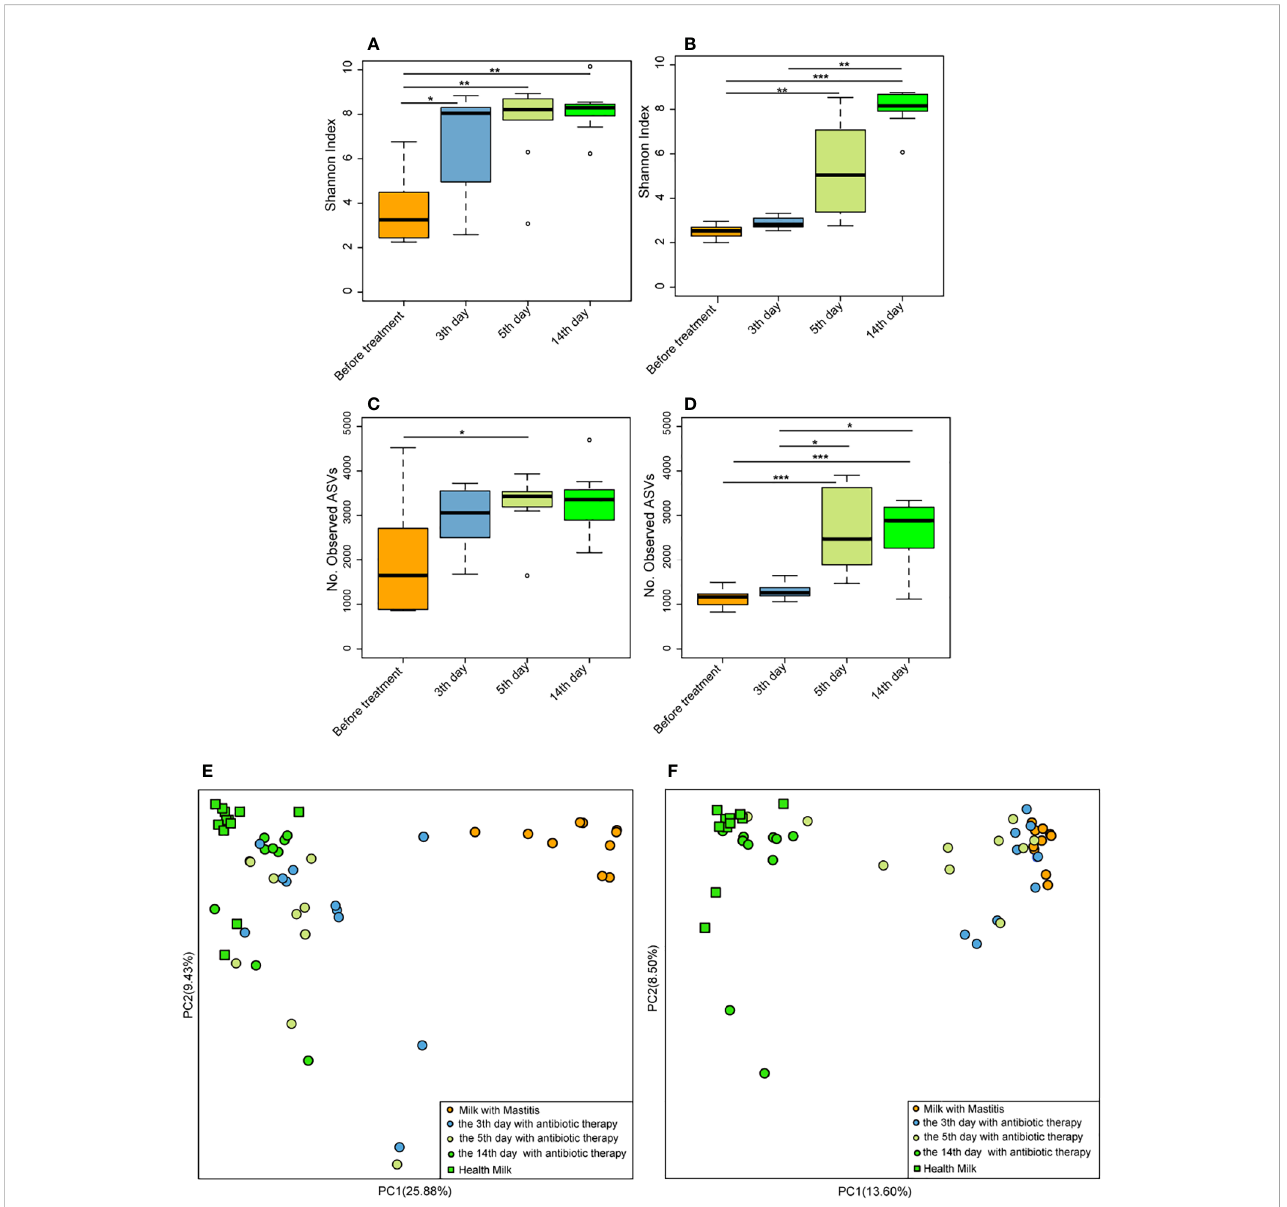
FIGURE 7 Effect of antibiotic and geraniol on milk microbiotas of dairy cows in the treatment of mastitis. Dynamic changes of Shannon index of milk microbiotas in dairy cows treated with antibiotics (A) andgeraniol (B) ; Dynamic changes of Number of observed ASVs of milk microbiotas in dairy cows treated with antibiotics (C) andgeraniol (D) ; Dynamic cluster of bacteria in milk of dairy cows with mastitis supported by Principal component analysis based on Weighted Unifrac distance before and after using antibiotic (E) and geraniol (F) (p values calculated by the One-way ANOVA test followed by post-hoc Dunn ’ s multiple comparisons test: ∗ < 0.05, ∗∗ < 0.01 and ∗∗∗ <